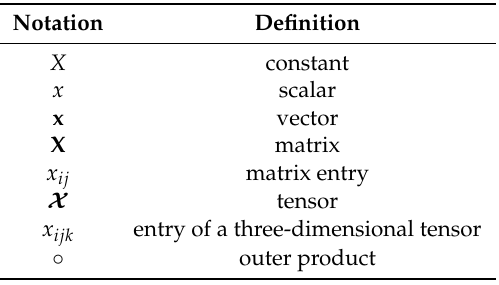
Table 1. Notation used throughout the